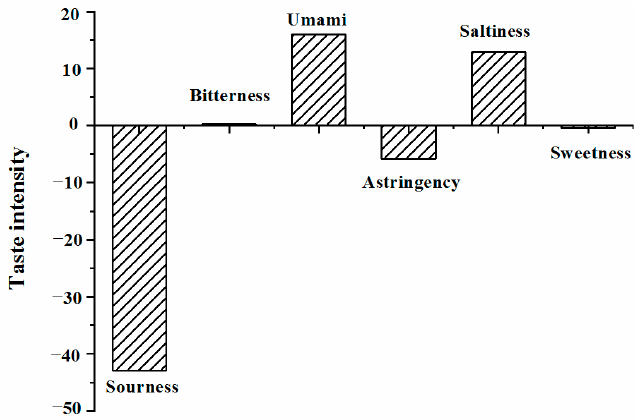
Figure 2. Enzymatic hydrolysis characteristics of